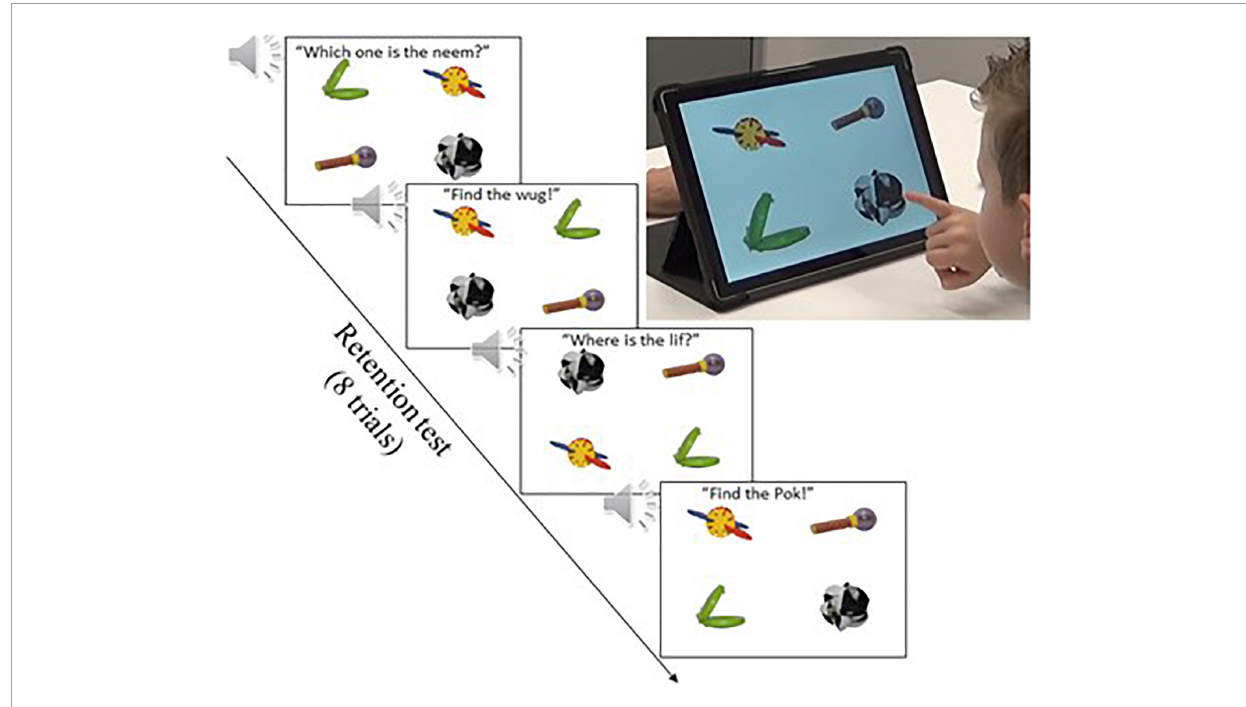
FIGURE5 Illustration of the immediate and delayed retention